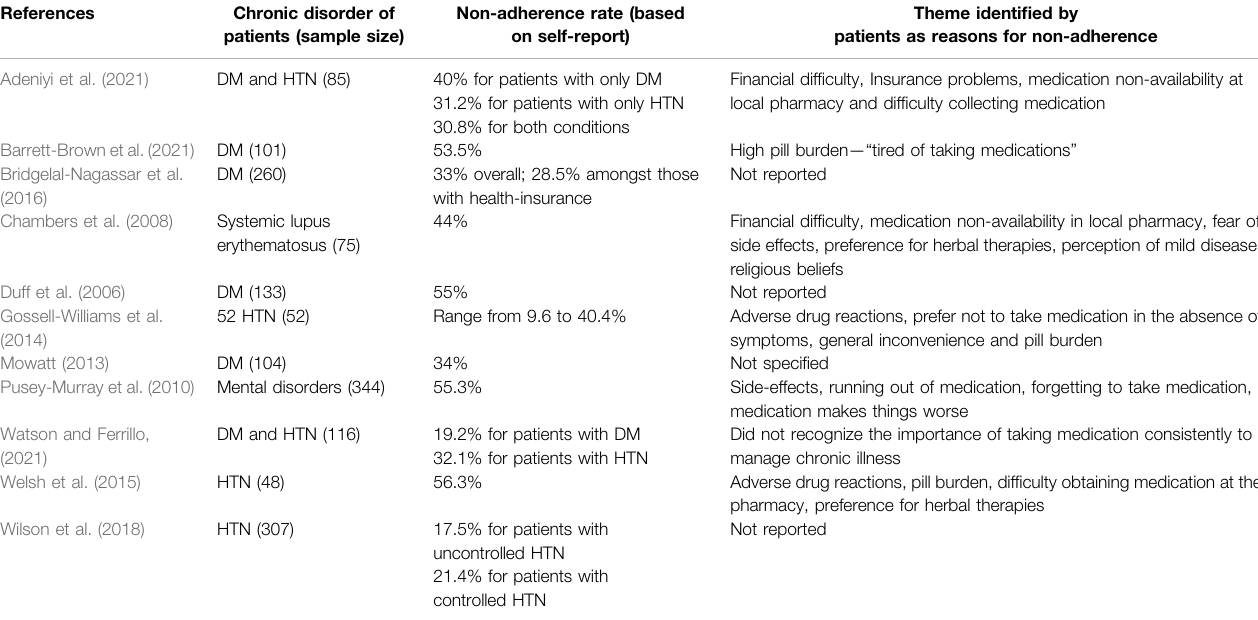
TABLE 1 | Overview of the studies presenting measures of non-adherences among Jamaicans living with NCDs. For all studies the measure of